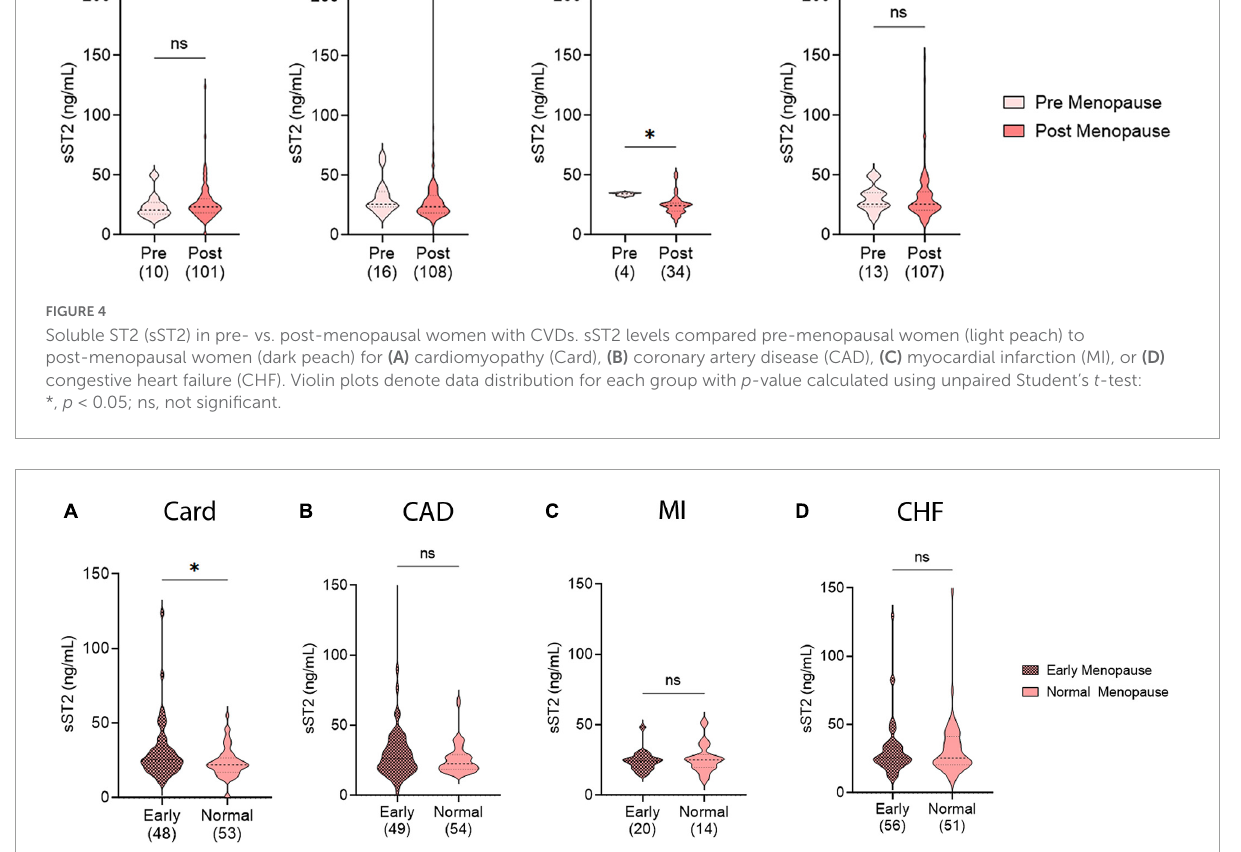
FIGURE5 Soluble ST2 (sST2) levels in women with early menopause. sST2 levels compared women with early menopause (Early, magenta) vs. those with normal menopause (peach) for (A) cardiomyopathy (Card), (B) coronary artery disease (CAD), (C) myocardial infarction (MI), or (D) congestive heart failure (CHF). Violin plots denote data distribution for each group with p -value calculated using unpaired Student’s t -test: *, p < 0.05; ns, not